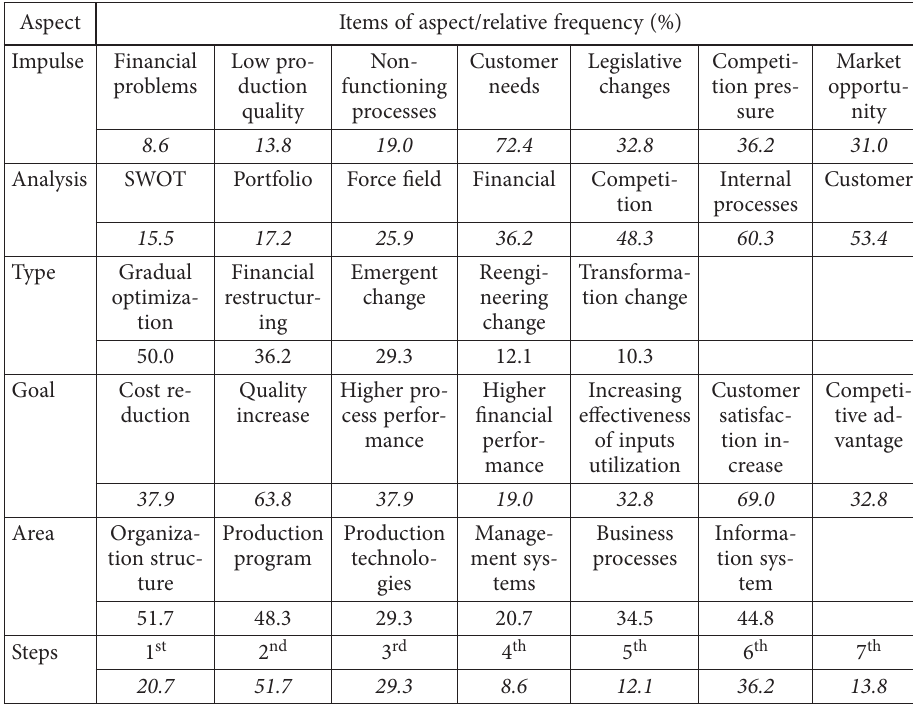
Table 4. Aspects of change management in enterprises with ROE over 10% (source: own processing)